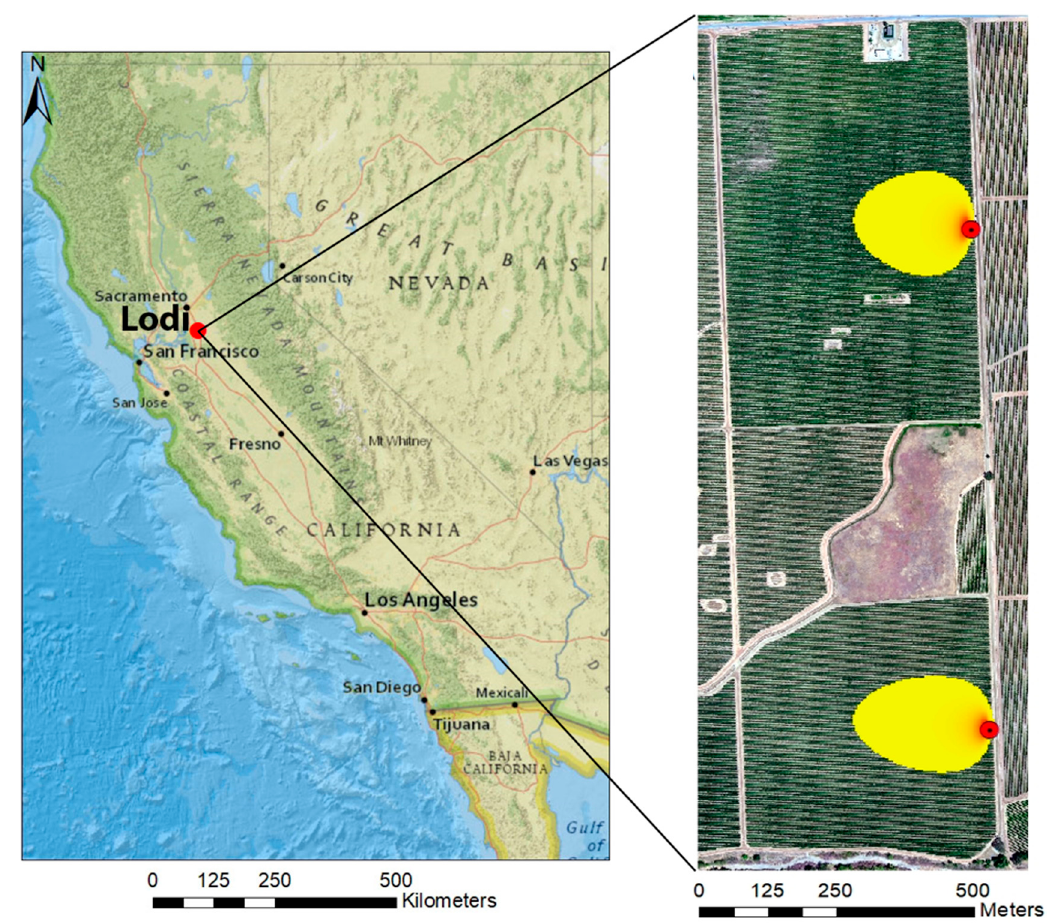
Figure 4. Layout of study area in Lodi, California, locations of EC towers and example of 90% of EC footprint at afternoon for 02 June 2015.